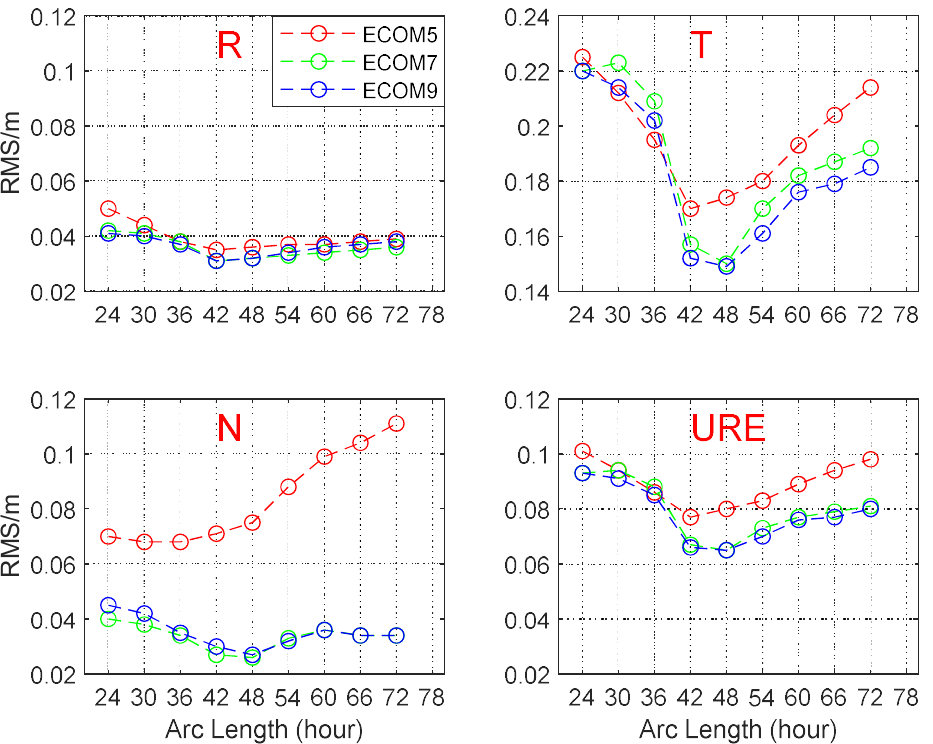
Figure 9. Average RMS and URE of BDS-3 predicted orbits with different ECOM SRP models in eclipse seasons (24 h prediction interval).